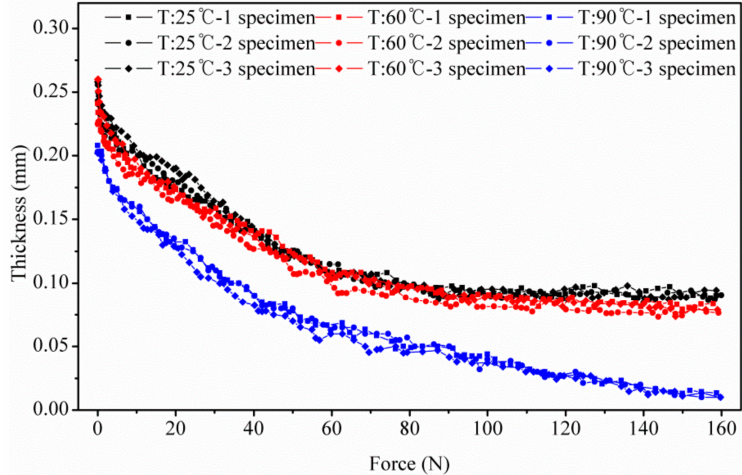
Figure 3. Temperature dependence of GDL’s thickness at compression